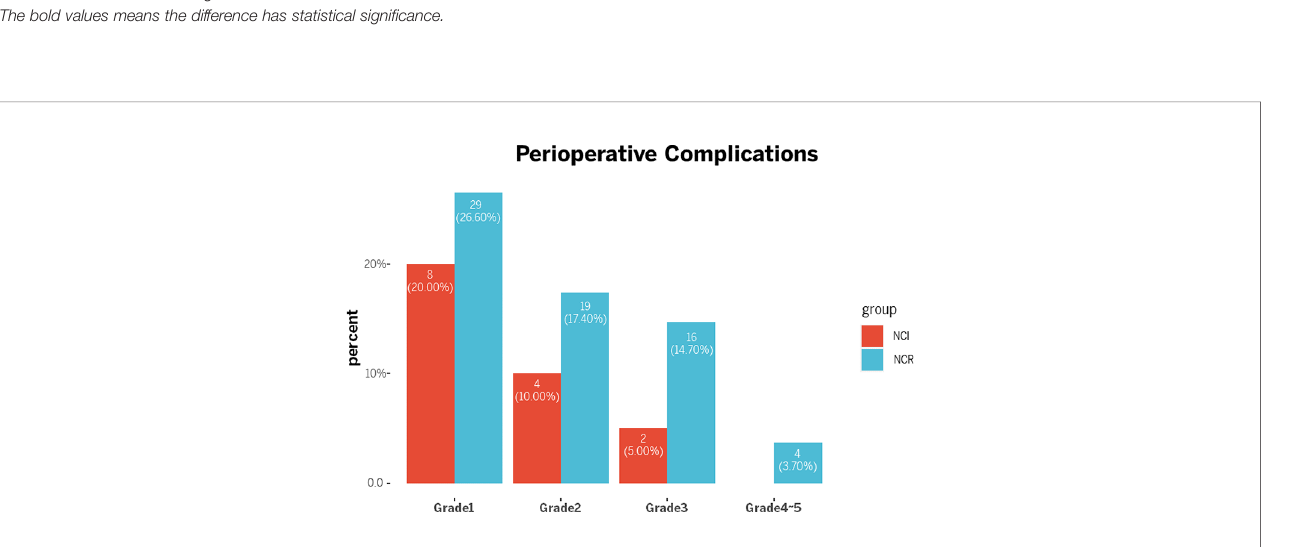
FIGURE 3 | Perioperative